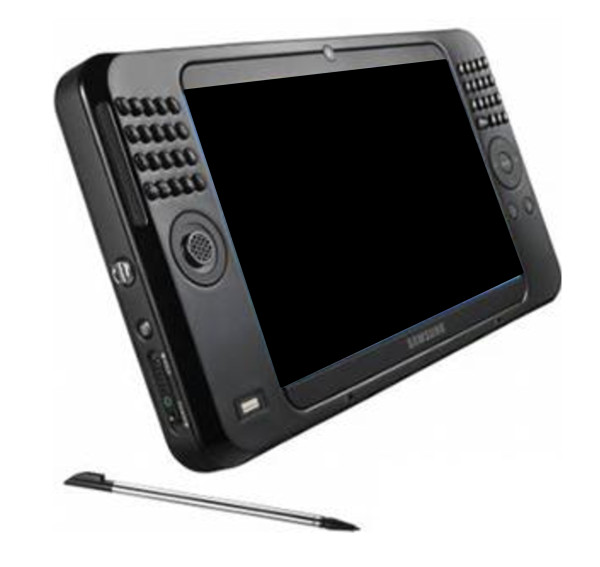
Ultra Mobile PC.